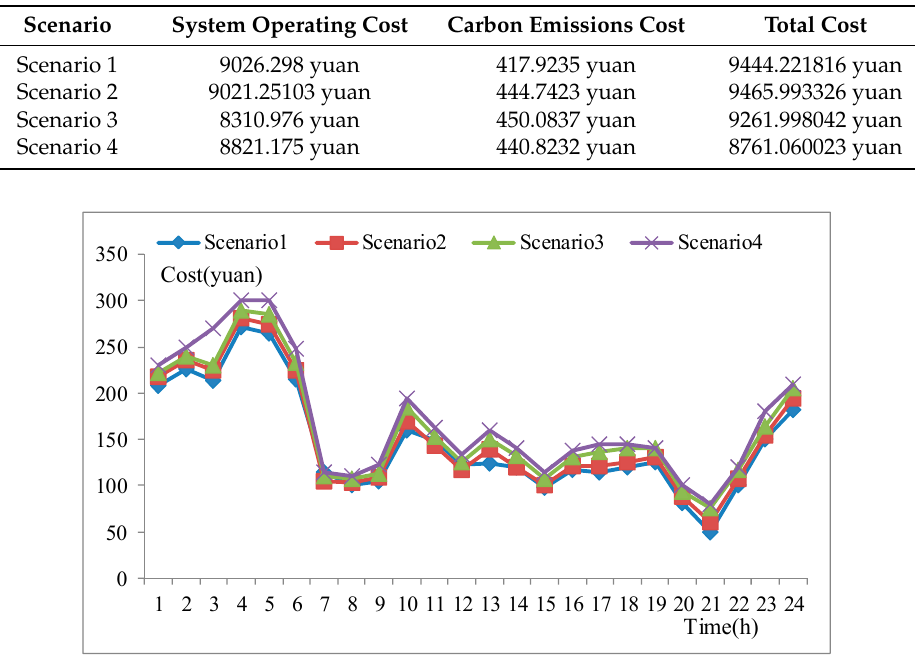
Figure 7. The system wind power and photovoltaic grid-connected capacity under different scenarios.